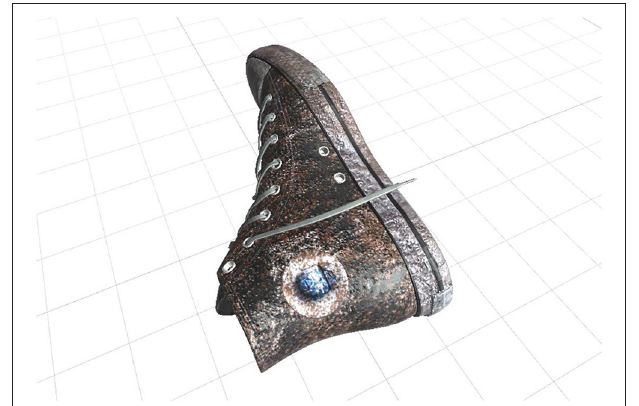
FIGURE 3 | Dirty sports shoe.